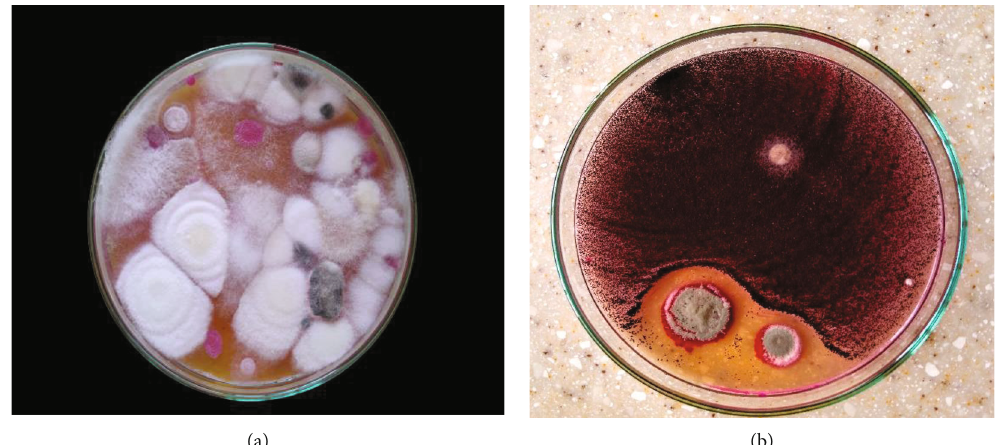
Figure 2: Macroscopic view of fungal species: (a) Fusarium oxysporum on gboma and (b) Aspergillus niger in dawadawa on DRBC